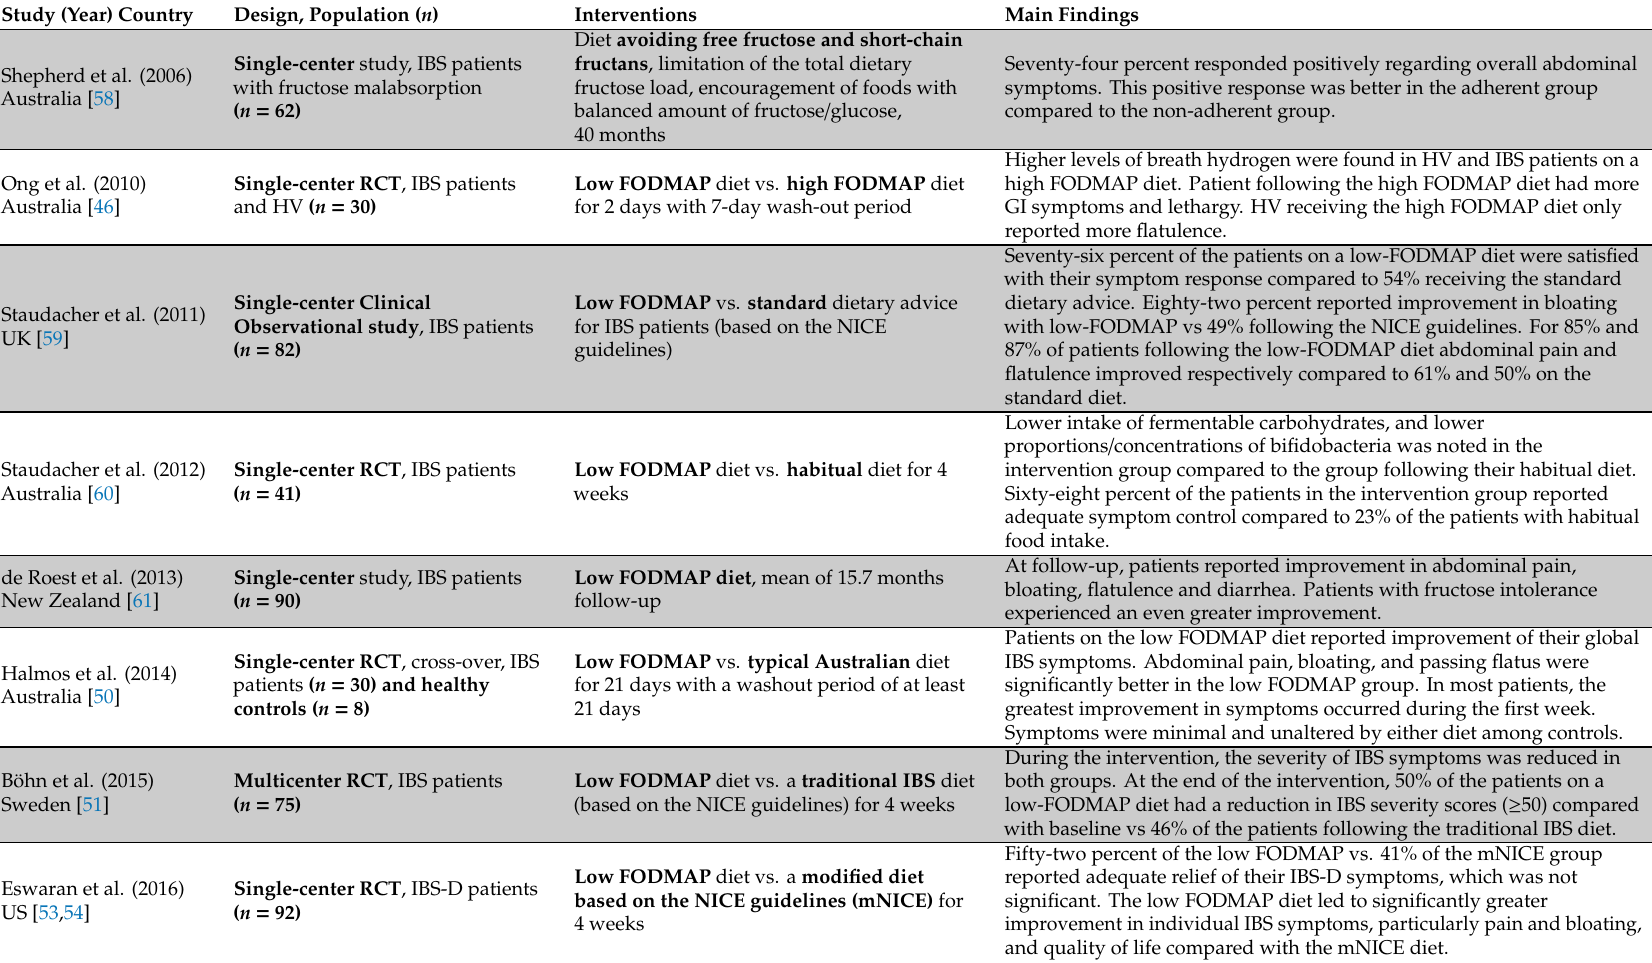
Table 1. Clinical trials evaluating the e ff ect of a low FODMAP in patients with